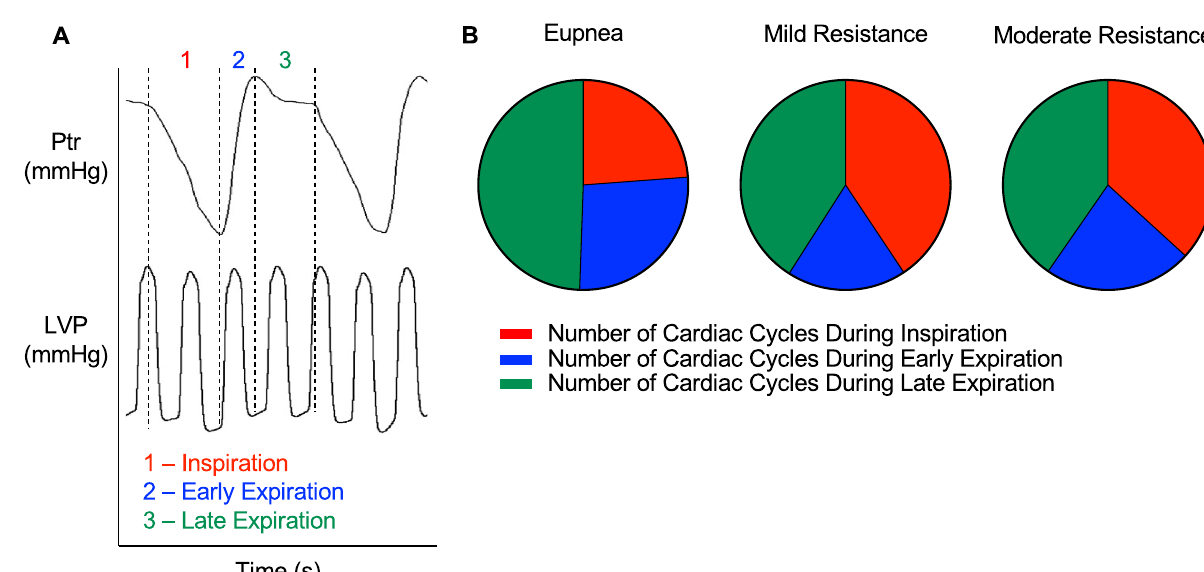
Figure 2. Respiration affects the number of cardiac cycles in each respiratory phase. Representative tracing for a mild respiratory load. Inspiratory (1, red), early expiratory (2, blue), and late expiratory (3, green) phases of respiration were identified by tracheal pressure (Ptr) ( A ). Inspiration was defined between the decline in Ptr and peak negative Ptr. Early expiration was defined between peak negative and maximum Ptr. Late expiration was defined as the plateau phase between maximum Ptr and the fall in Ptr at the start of inspiration. Left ventricle pressure (LVP) was recorded simultaneously with Ptr and parameters of cardiac function were separated by respiratory phase. ( B ) Graphical representation of the number of cardiac cycles that occur during inspiration, early expiration, and late expiration. Data are presented as mean values, n = 7.